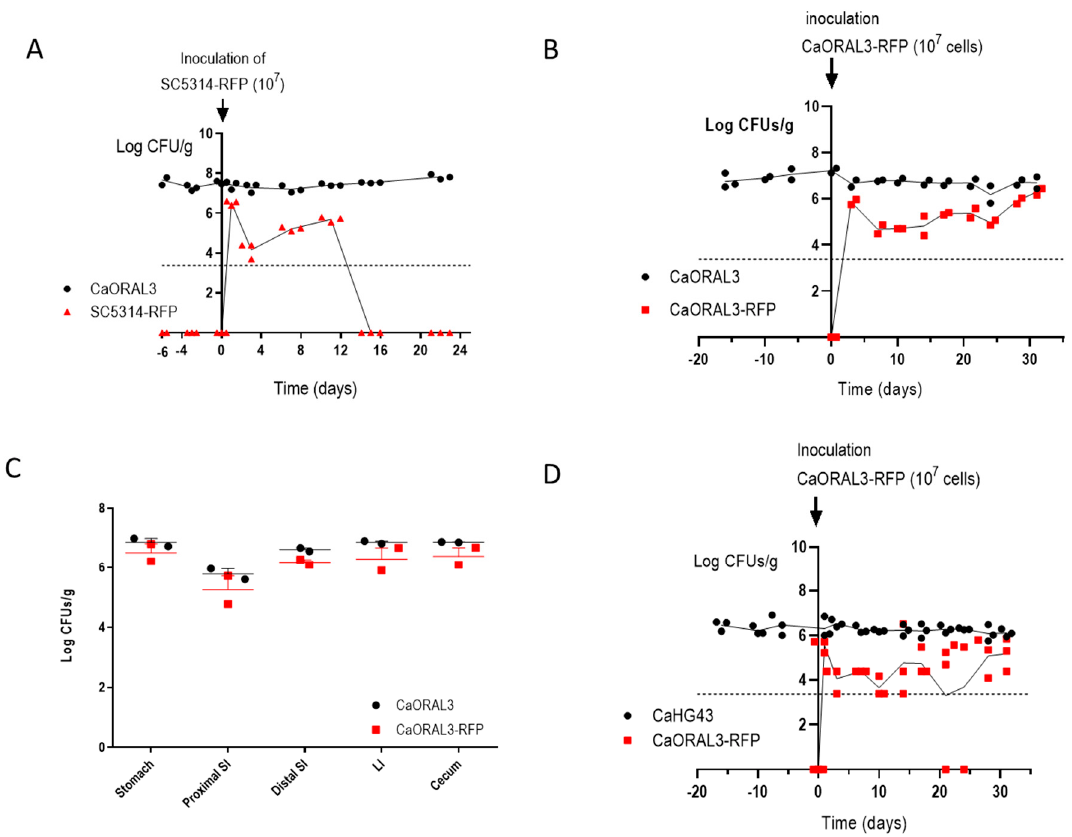
Figure 7. Competition between CaORAL3 and other C. albicans strains in the murine commensalism model. ( A ) 10 7 SC5314-RFP cells were inoculated in mice previously colonized by CaORAL3 cells and without antibiotic treatment for 39 days. Colonization load was followed in time by spreading stool suspension on SD-chloramphenicol medium to distinguish white/red colonies. ( B , D ) 10 7 CaORAL3 cells tagged with RFP were inoculated in mice previously colonized by ( B ) CaORAL3 or ( D ) CaHG43 strains and without antibiotic treatment for 39 days. Colonization load was followed similarly. ( C ) At the end of the experiments, mice from groups in ( B ) were euthanized and the amount of each strain was quantified in the different portions of the gastrointestinal tract.